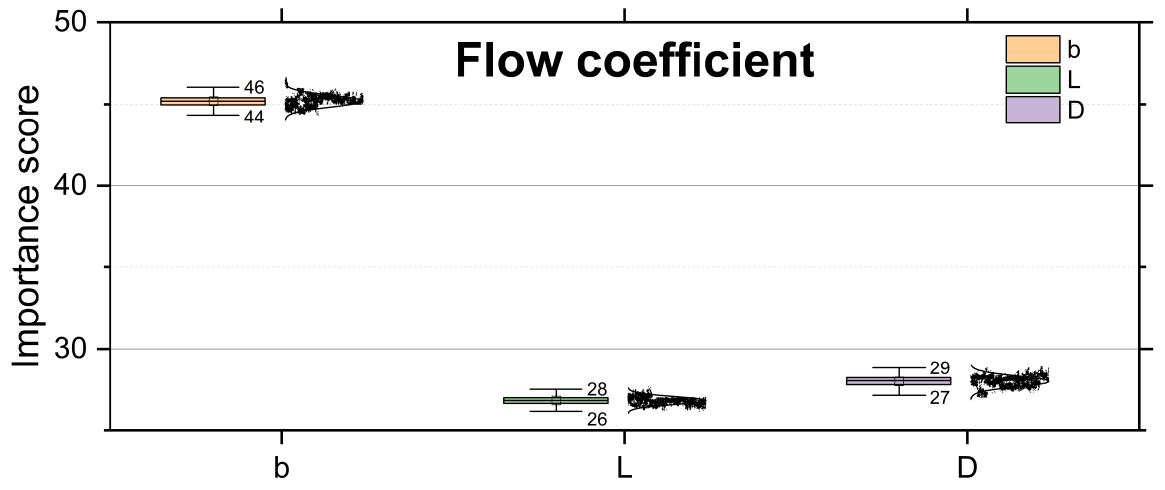
Figure 17. Importance score of the input variables for the prediction model of the emitter flow coefficient.